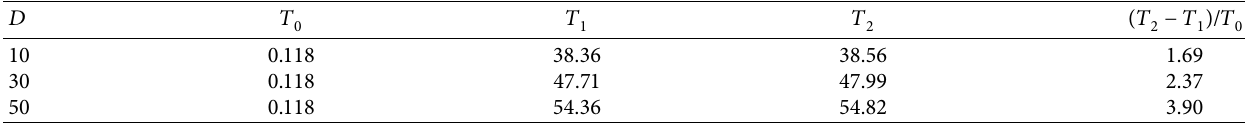
Table 7: Computational complexity analysis on the CEC 2005